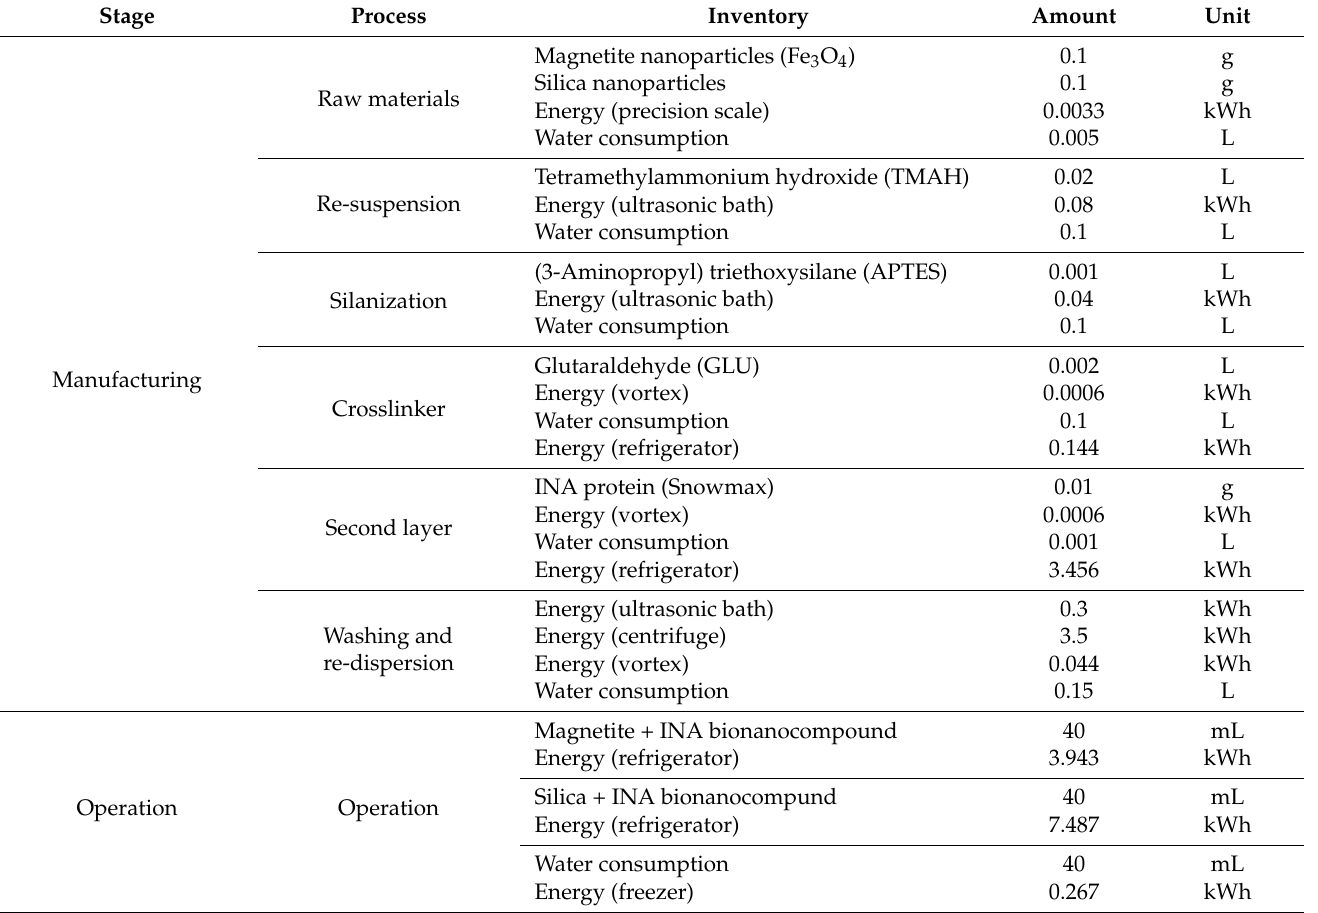
Table 1. Inventory report for each stage